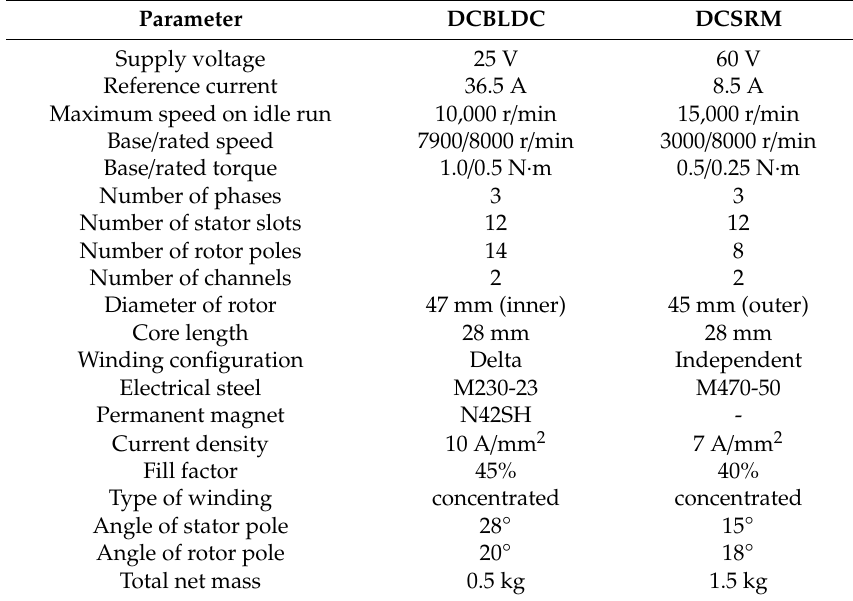
Table 1. Main parameters of the BLDC motor and the SRM for SCO